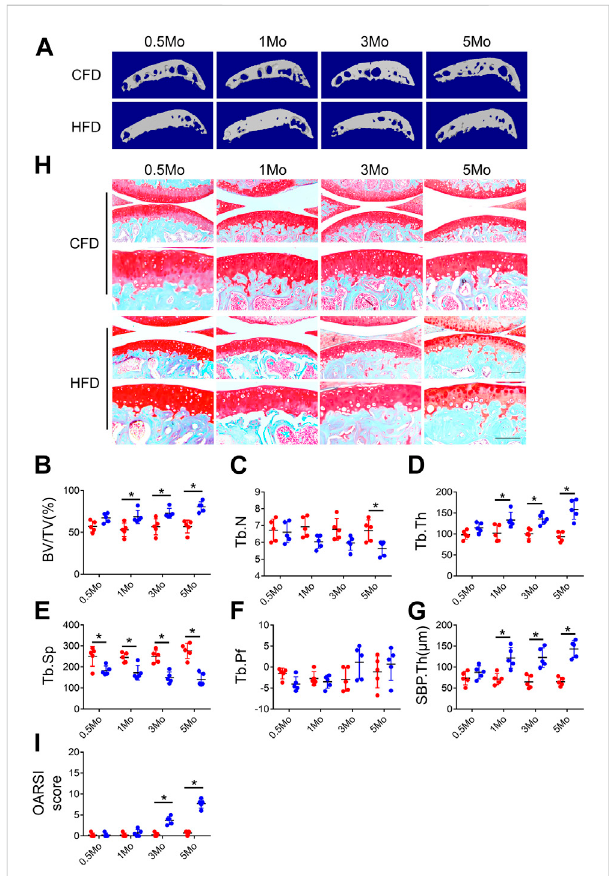
FIGURE 1 EvaluationofcartilageandsubchondralbonephenotypeinHFD- treated mice. Three-month-old C57BL/6 mice were fed a chow-food diet (CFD) or ahigh-fatdiet (HFD) for 0.5, 1, 3, or 5 months. n= 6mice per group. (A – G) Representative image of three-dimensional micro-computed tomography ( μ CT) images (A) and quantitative analysisofstructuralparametersofkneejointsubchondralbone:bone volume/tissue volume (BV/TV, %) (B) , trabecular number (Tb.N, mm − 1 ) (C) trabecular thickness (Tb.Th, mm) (D) , trabecular bone separation (Tb. Sp, mm) (E) , trabecular pattern factor (Tb. Pf, mm − 1 ) (F) , and subchondral bone plate thickness (SBP. Th, mm) (G) . (H, I) Safranin O-fast green staining of the tibia subchondral bone medial compartment (sagittal view) (H) and calculation of Osteoarthritis ResearchSocietyInternational(OARSI)scores (I) .Alldataareshownas means ± standard deviations. * p < 0.05. Statistical signi fi cance was determined by unpaired, two-tailed Student ’ s